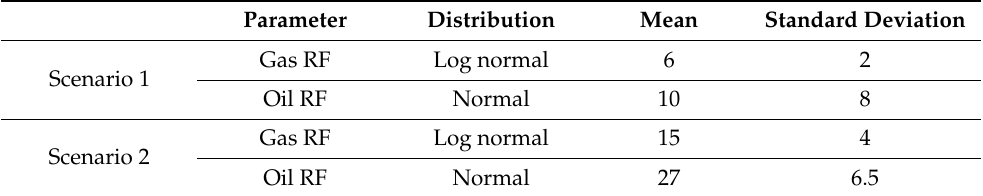
Table 7. Summary of distribution inputs of recovery factors.